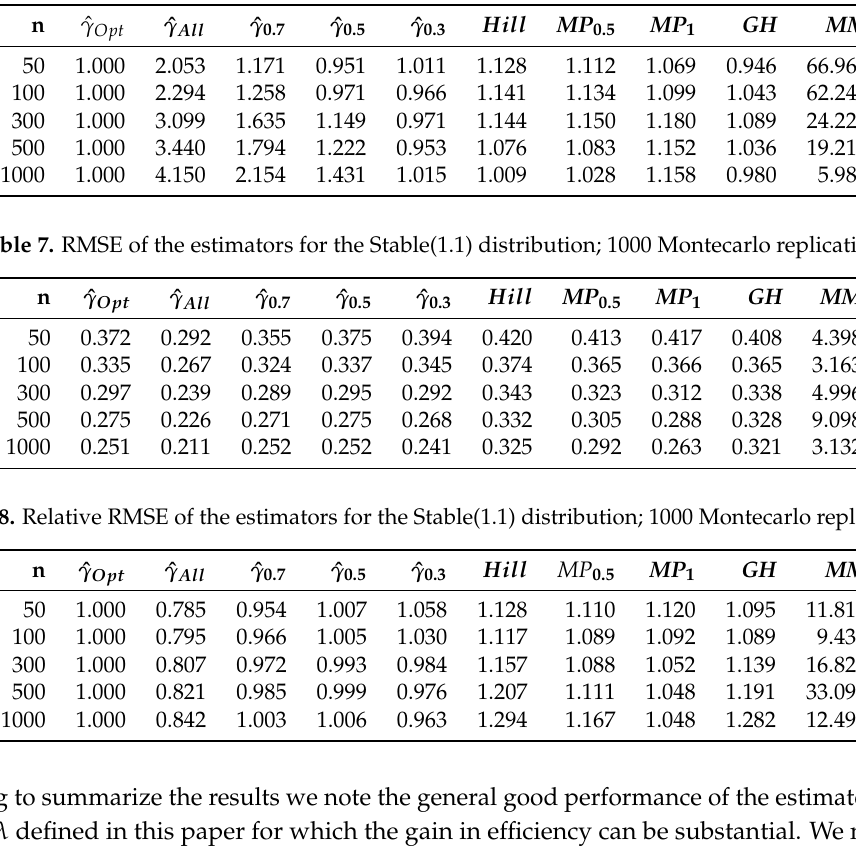
Table 6. Relative RMSE of the estimators for the Burr(2) distribution; 1000 Montecarlo replications.